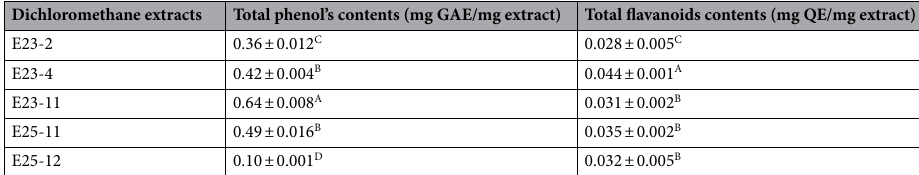
Table 6. Total phenolic and flavonoid contents of dicholoromethane extract of Actinomycetes. Values expressed are means ± SD (n = 3). In each column, averaged means within followed by the same letters are not significantly different according to one-way (ANOVA) using Tukey’s multiple comparisons test, P < 0.05.